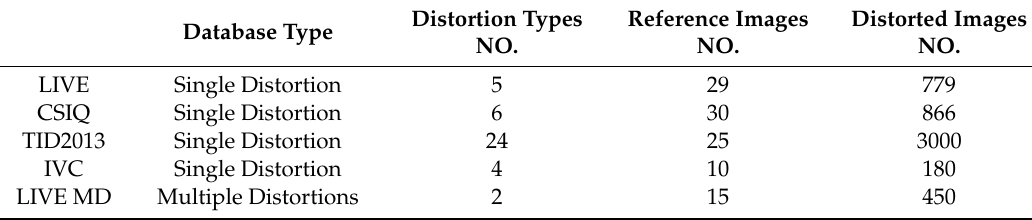
Table 1. Details of generated IQA